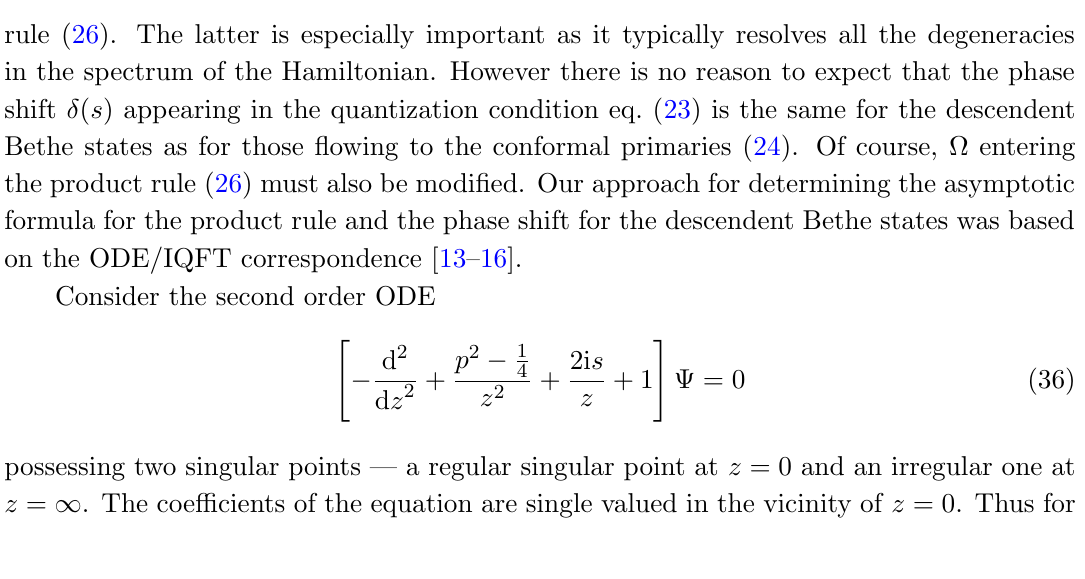
shift (cid:14) ( s ) appearing in the quantization condition eq. (23) is the same for the